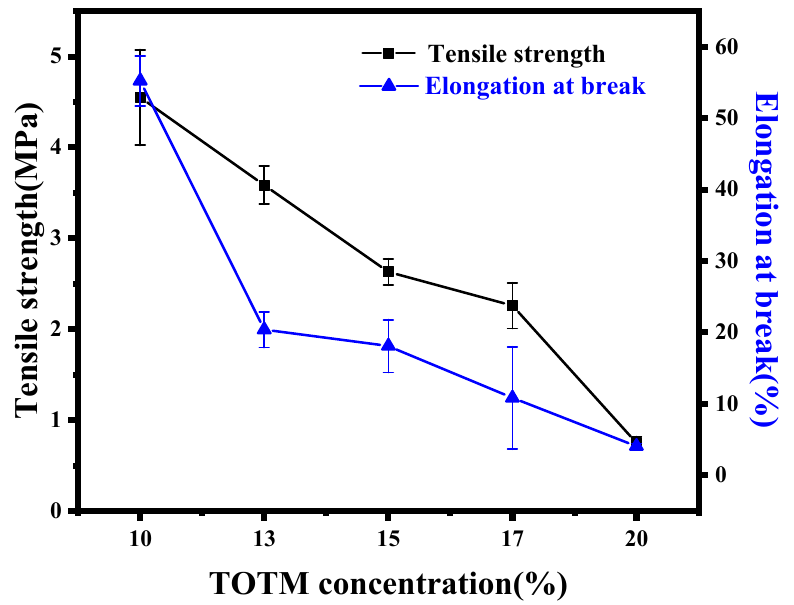
Figure 8. Mechanical properties of ECTFE membranes prepared with different TOTM contents.